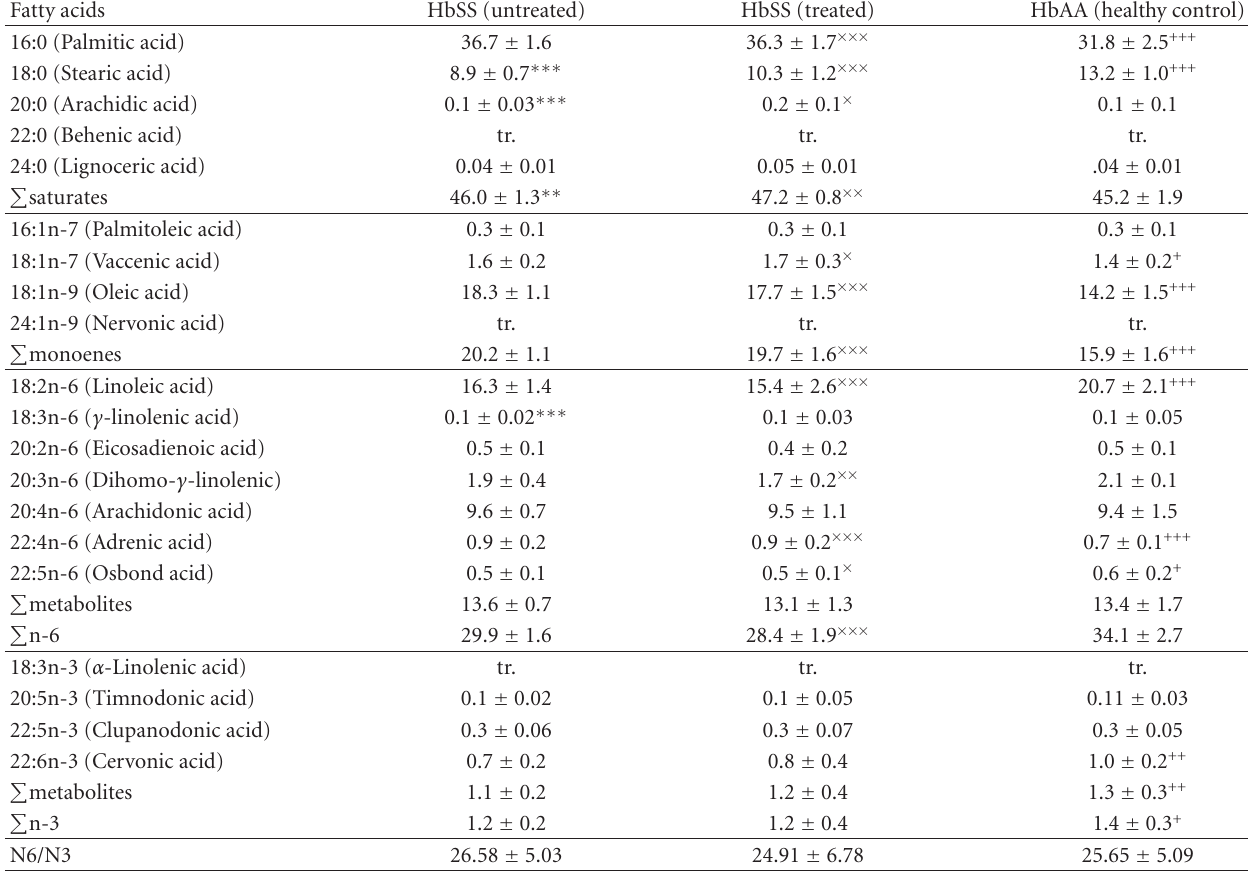
Table 3: Fatty acid composition of red blood cell choline phosphoglycerides of HU-untreated ( n = 17) and treated ( n = 19) HbSS patients and HbAA controls ( n =